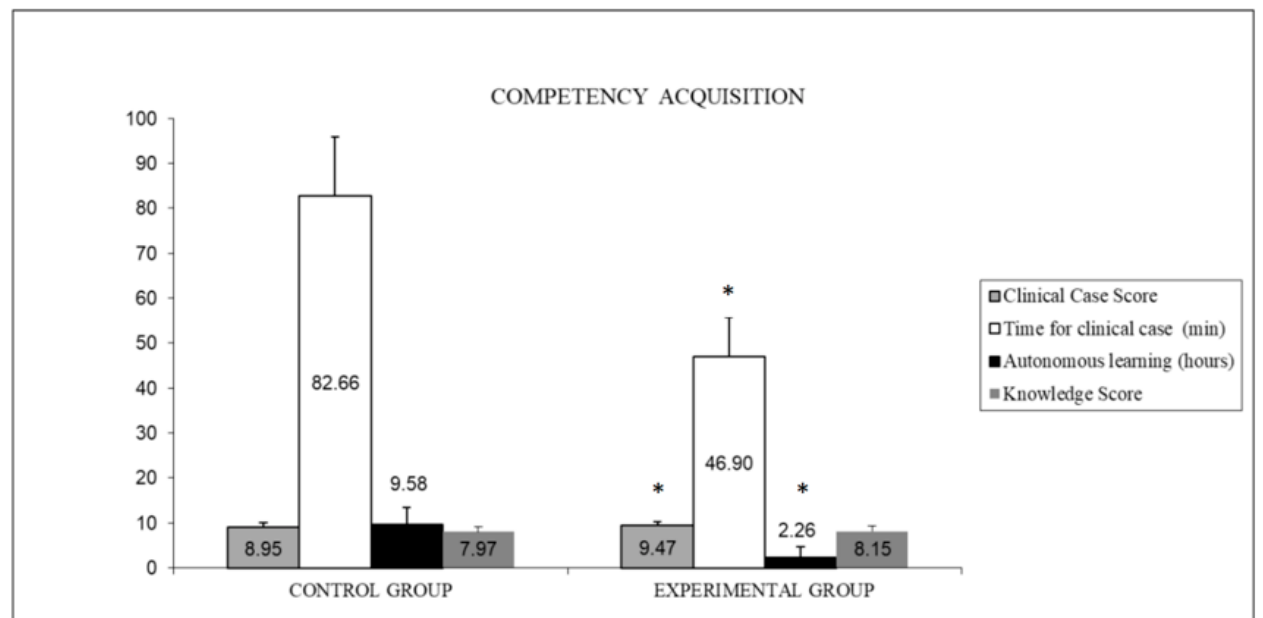
Figure 2. Comparison of knowledge and skill competencies between groups at the end of the program.